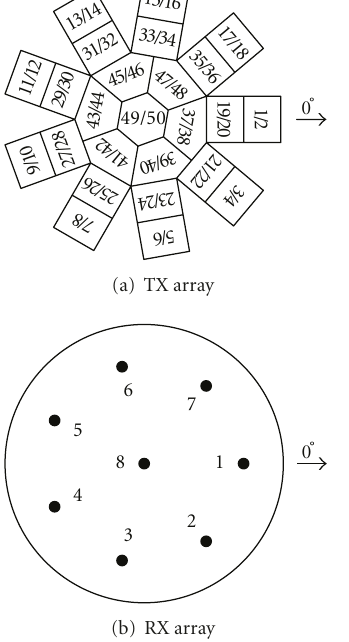
Figure 4: Schematic plots of the antenna arrays used in the measurements.